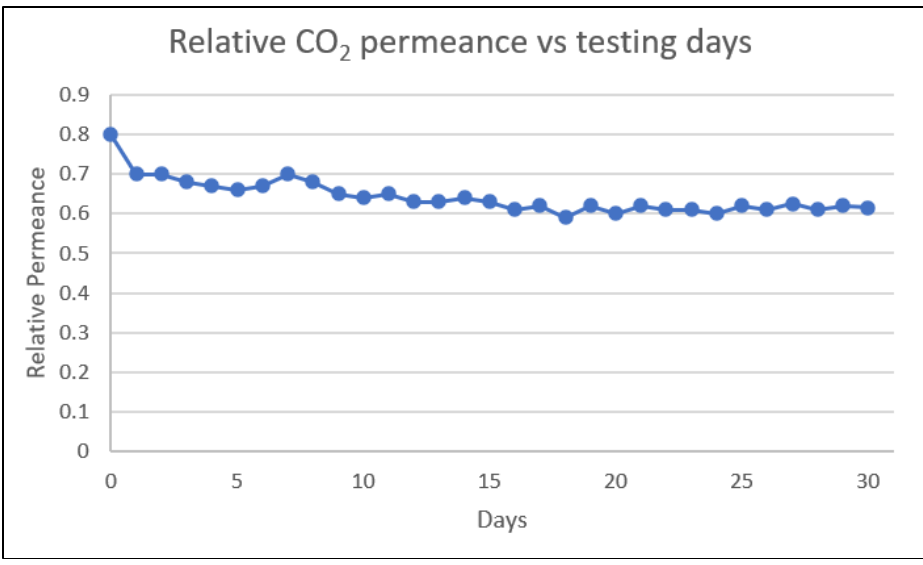
Figure 10. Relative CO 2 permeance vs. testing days trend showing the membrane stability.